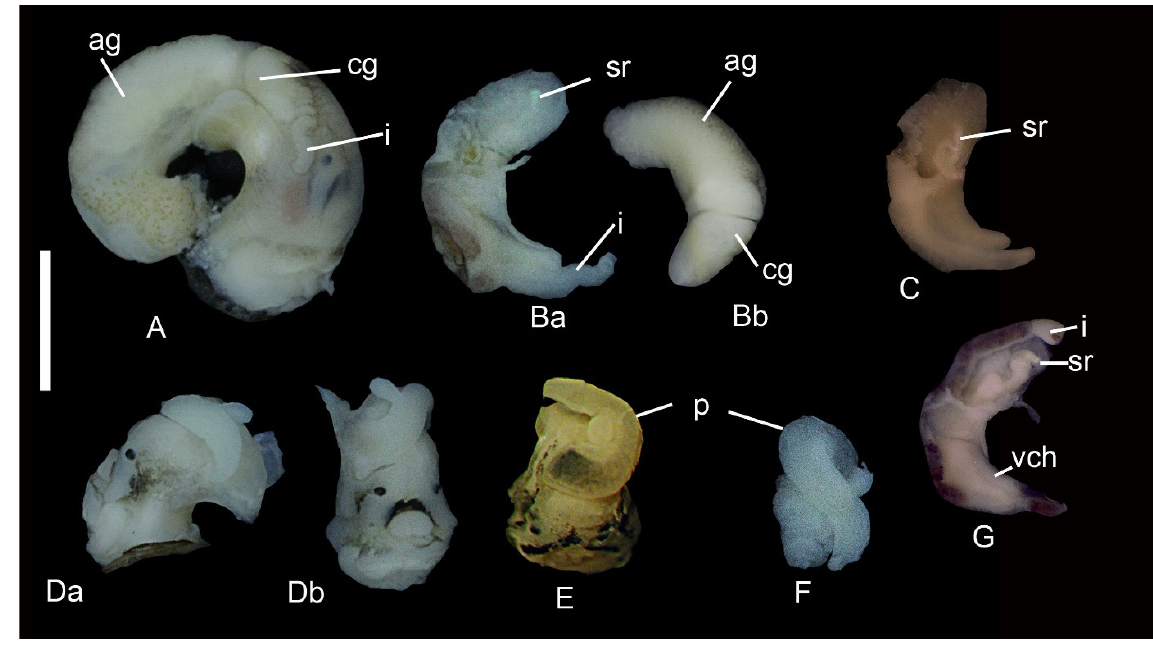
Figure 5. Soft bodies of Kolhymamnicola . ( A ) K. miyadii , female, the whole body, right side (shell, see Figure 1Ha). ( Ba ) K. miyadii , the same specimen, gonoduct, ventral view. ( Bb ) the same specimen, gonoduct, dorsal view. ( C ) K. ochotica , female gonoduct (shell, see Figure 1K); ( Da,Db ) K. miyadii , male (shell, see Figure 1Hb), the front part of the body with penis; ( Da ) the left side; ( Db ) frontal view; ( E ) K. miyadii , male, the front part of the body with penis (shell, see Figure 1Gb); ( F ) K. cf. wasiliewae , penis (shell, see Figure 1P); ( G ). K. cf. wasiliewae , female gonoduct (shell, see Figure 1R). Scale bars 1 mm. Abbreviations: ag—albumen gland, cg—capsule gland, i—intestine, p—penis, sr—seminal receptacle, vch—ventral channel.